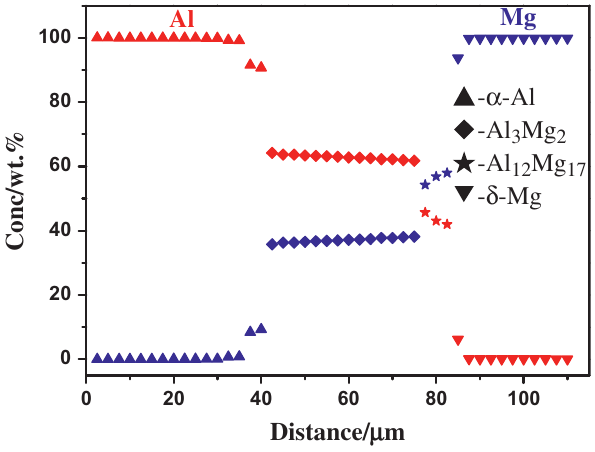
Figure 4: Concentration distribution of the joints interface at 748K with 90